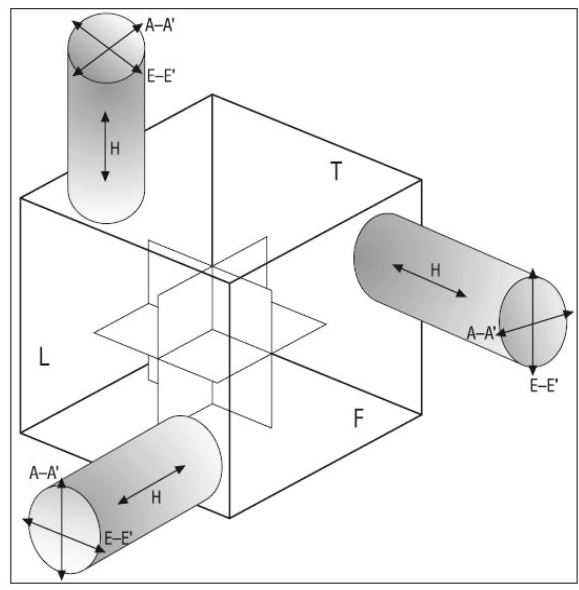
Fig. 2. The orientation of the sample